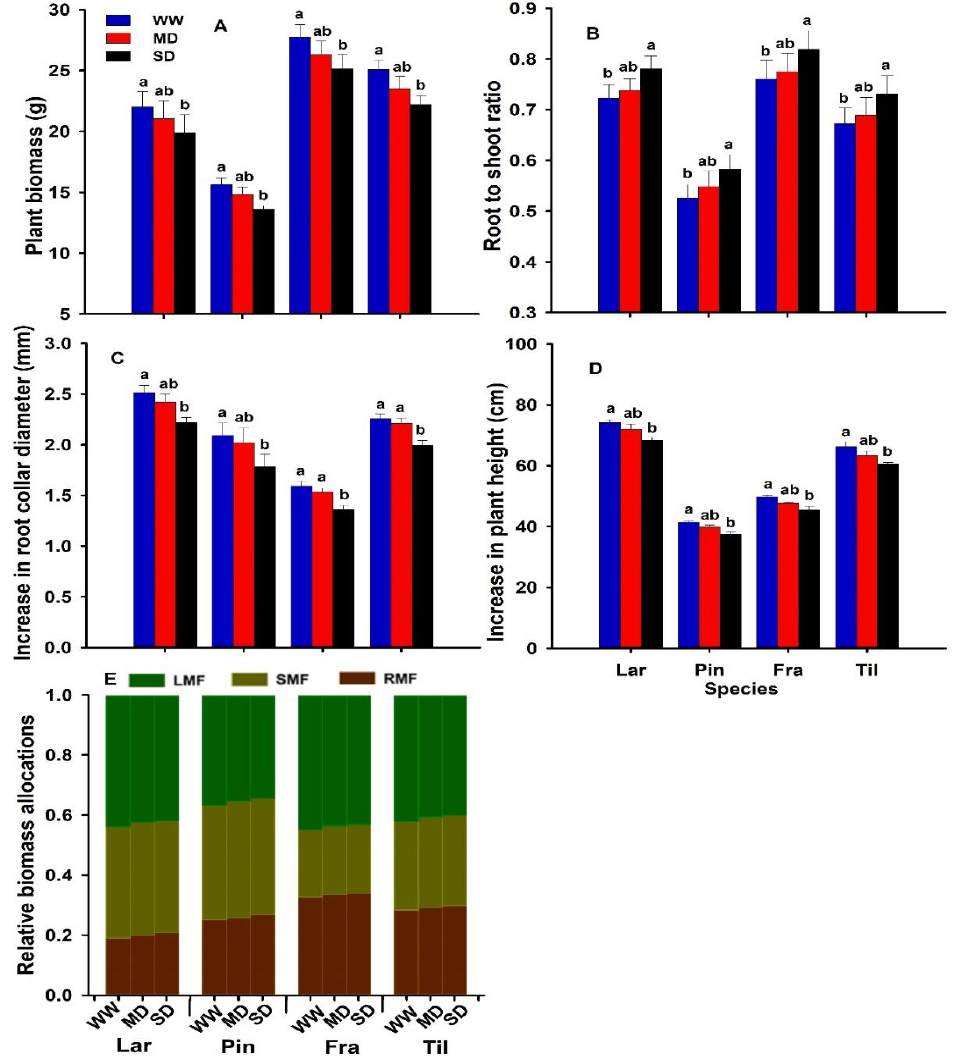
Figure 1. Plant biomass (PB; g) ( A ), root shoot ratio ( B ), increase in root collar diameter (RCD; mm) ( C ), increase in plant height (PH; cm) ( D ), and relative biomass allocation ( E ); root mass fraction (RMF; grey bars), stem mass fraction (SMF; light grey bars), and leaf mass fraction (LMF; green bars) of two-year-old seedlings of Larix gmelinii (Lar), Pinus koraiensis (Pin), Fraxinus mandshurica (Fra), and Tilia amurensis (Til) at severe drought, SD, ≤5%; moderate drought, MD, 6– 10%; and well-watered, WW, 16 – 20%.